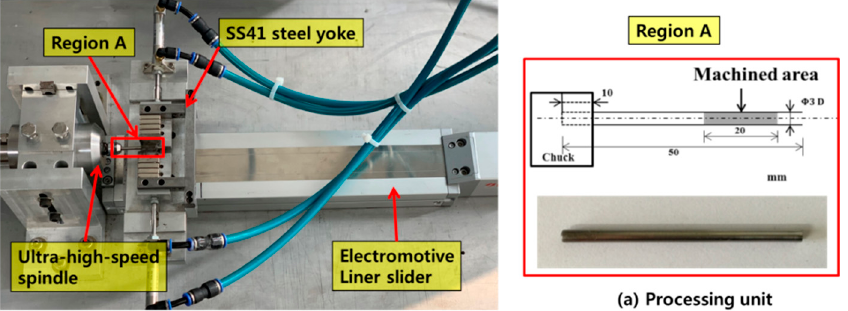
Figure 3. Photo of ultra-high-speed magnetic abrasive machining (UHSMAM) process apparatus with cylindrical workpiece.